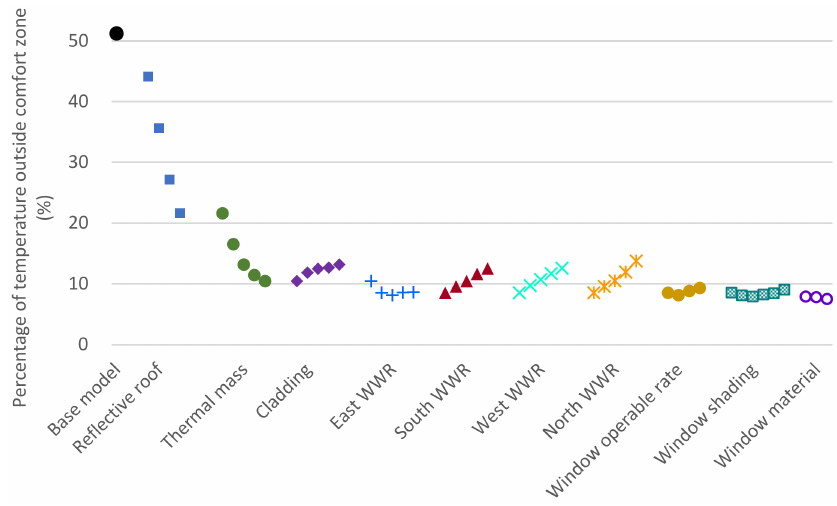
Figure 7. Multiple parameter optimization and the reduction in the percentage of operative tempera- tures outside the adaptive comfort zone during daytime hours.